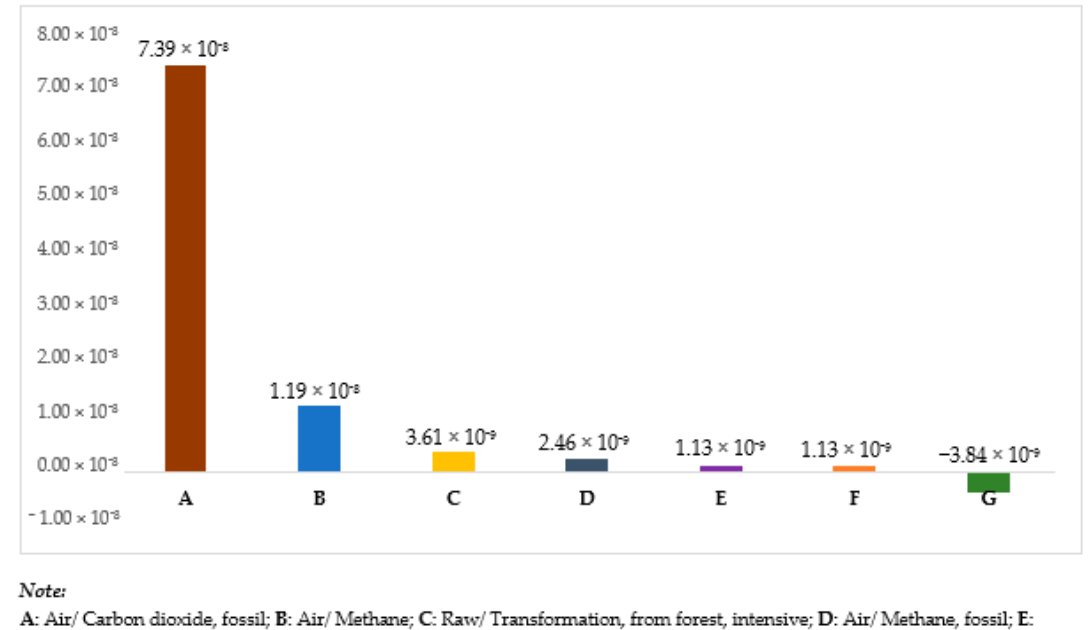
Figure 11. Ecosystem damage assessment of 1 kg of SPF-reinforced sago starch composite takeout food container analyzed (damage assessment/excluding long-term emissions/cut off 1%).